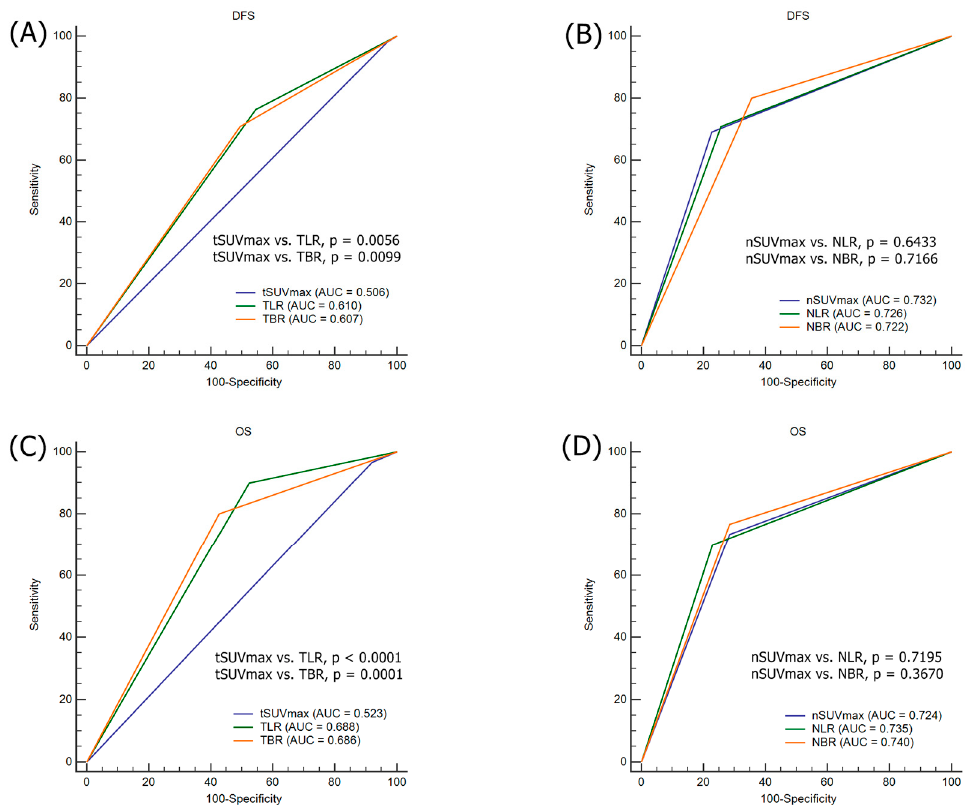
Figure 3. Comparison of ROC curve analyses. ( A ) tSUV max versus TLR and TBR for DFS. ( B ) nSUV max versus NLR and NBR for DFS. ( C ) tSUV max versus TLR and TBR for OS. ( D ) nSUV max versus NLR and NBR for OS.